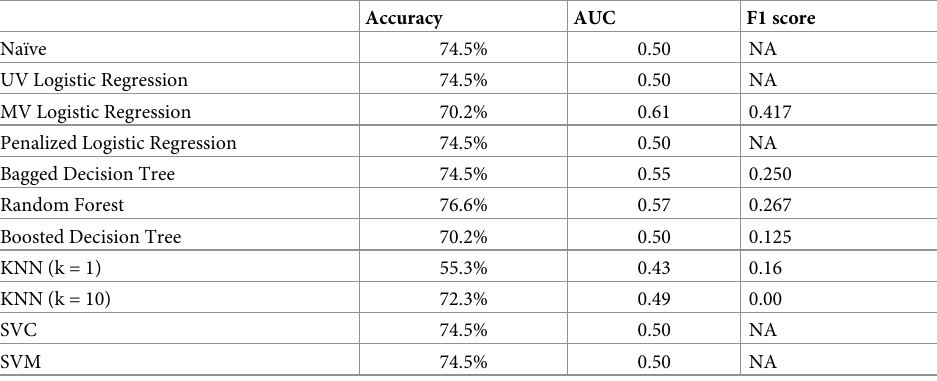
Table 3. Predictive accuracy of different models for VT episodes.